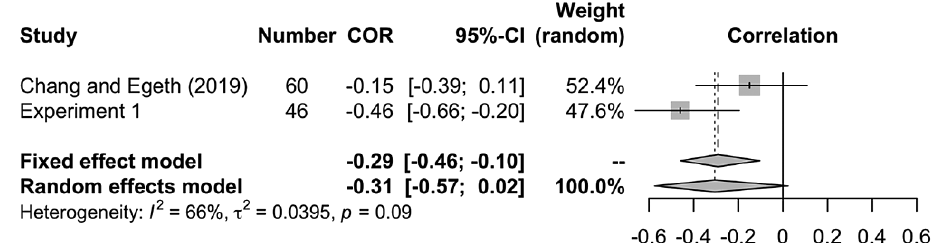
Figure 6. Meta-analysis of studies on the correlation between target enhancement and distractor suppres- sion. Forest plot indicates pooled individual-study Pearson ’ s correlation coefficients with corresponding 95% CIs. Random effect model showed a marginal negative correlation between target enhancement and distractor sup- pression ( r = (cid:3) .31, 95% CI [ (cid:3) .57, .02], p = .068), suggesting that they are not mutually